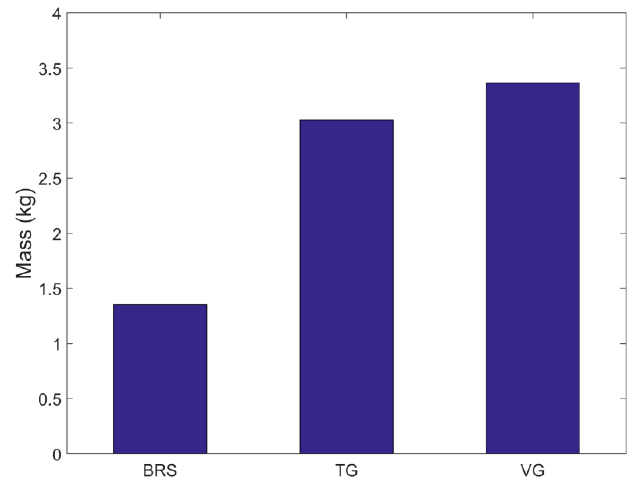
Figure 12. Total casting mass.